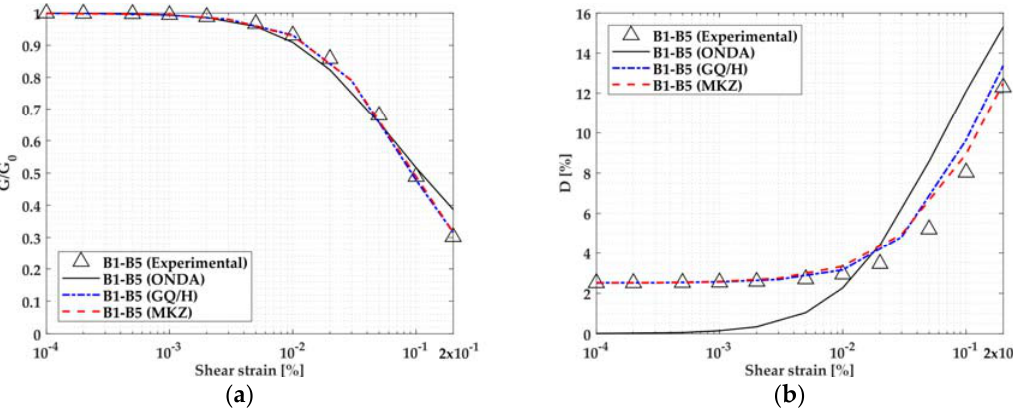
Figure 11. Comparison between the experimental and the adopted: ( a ) modulus reduction curve; ( b ) damping ratio curve (Upper Pancone). In this Figure, triangles represent the best-fit of the collected experimental data related to the Upper Pancone as reported in [7].